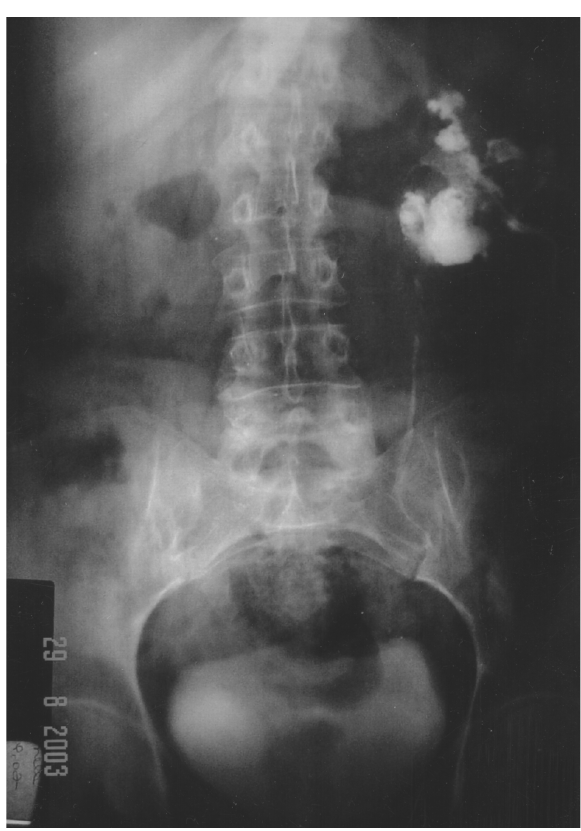
Figure 2 – Fistulography performed from the fistulous orifice in the skin on lumbar region, demonstrates contrast agent in the collecting system of the left